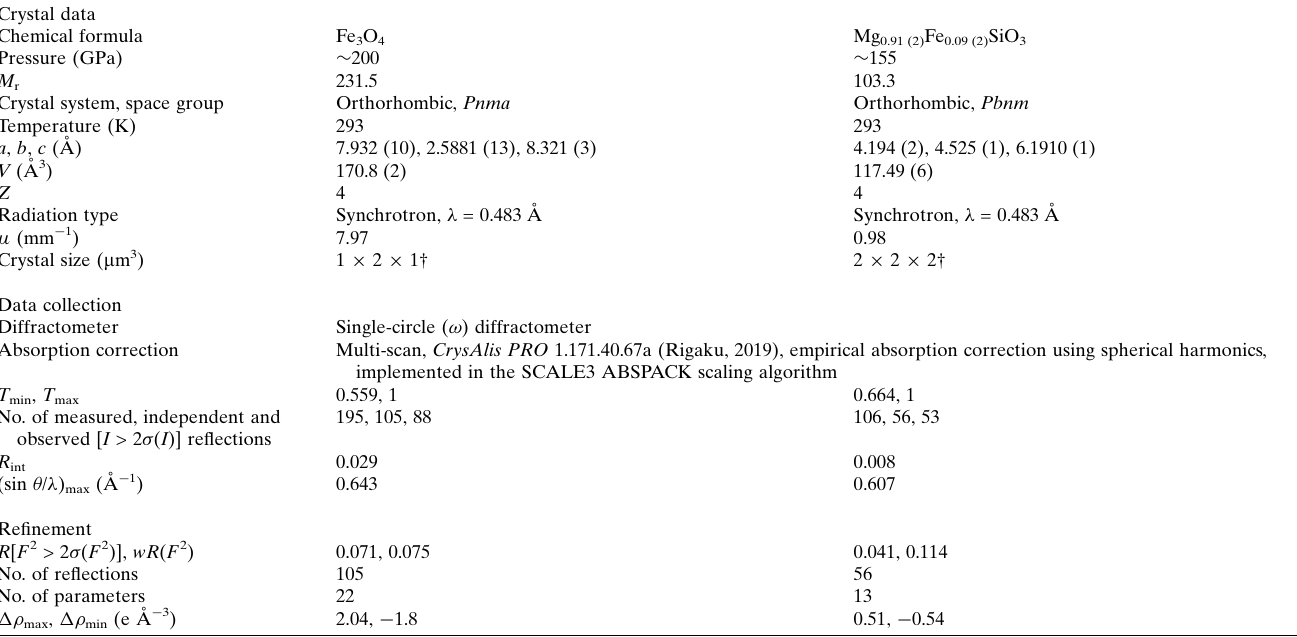
Table 3 Detailed information for the crystal structure refinements of oP-Fe 3 O 4 and Mg 0.91 (2) Fe 0.09 (2) SiO 3 performed on laser-heated samples at ultra-high pressures. Samples were measured at ambient temperature after a laser-heating procedure. For additional information on the crystal structures and refinement parameters we refer the reader to the CIFs in the supporting information. Crystal data Chemical formula